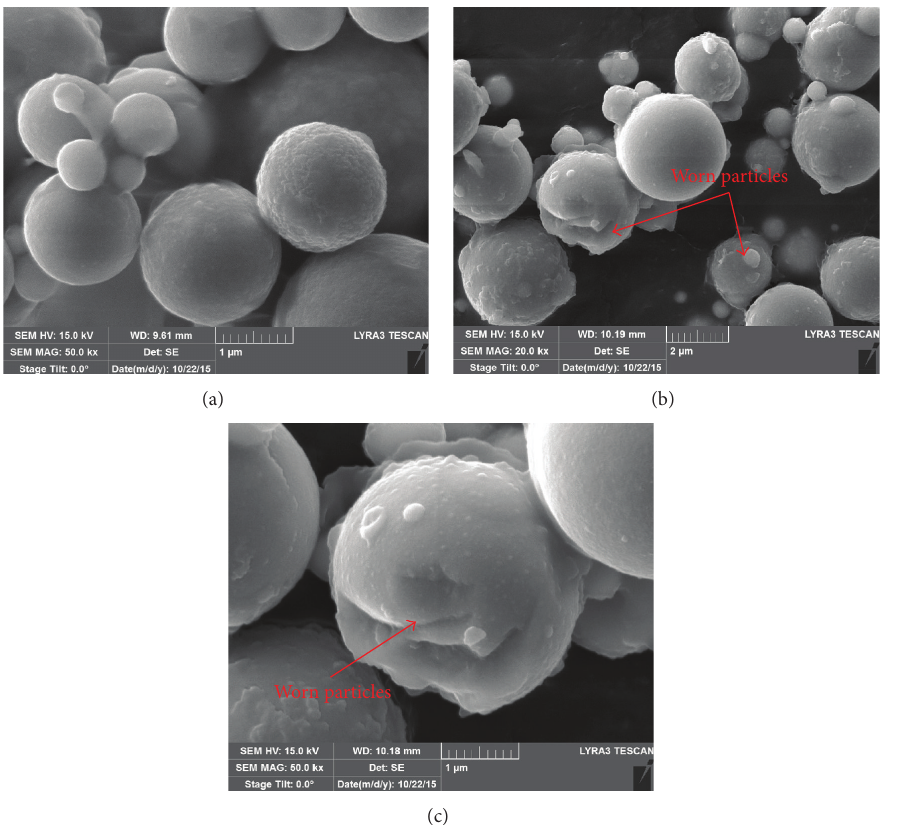
Figure 7: (a) Image of magnetic particles in MRF obtained before wear experiment. (b) Image of worn magnetic particles under 20000 times’ amplification. (c) Image of worn magnetic particles under 50000 times’